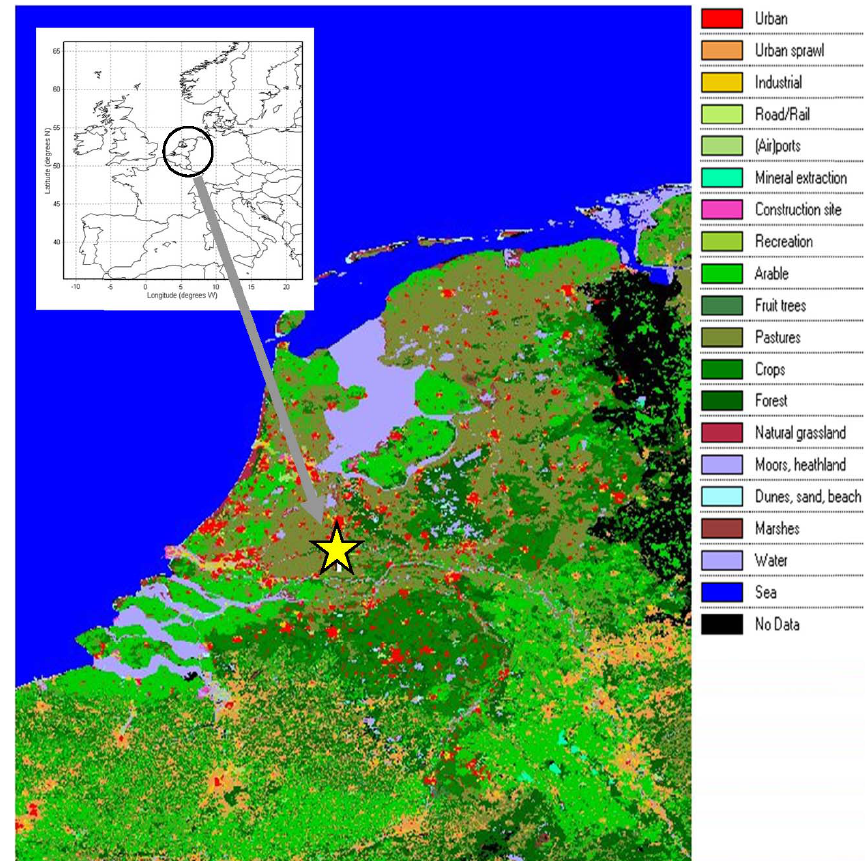
Fig. 1. Cabauw measurement location (yellow star) and Corine 2000 (http://image2000.jrc.ec.europa.eu/) land use for the surrounding area. The area displayed in the color map is approx. 300 ×